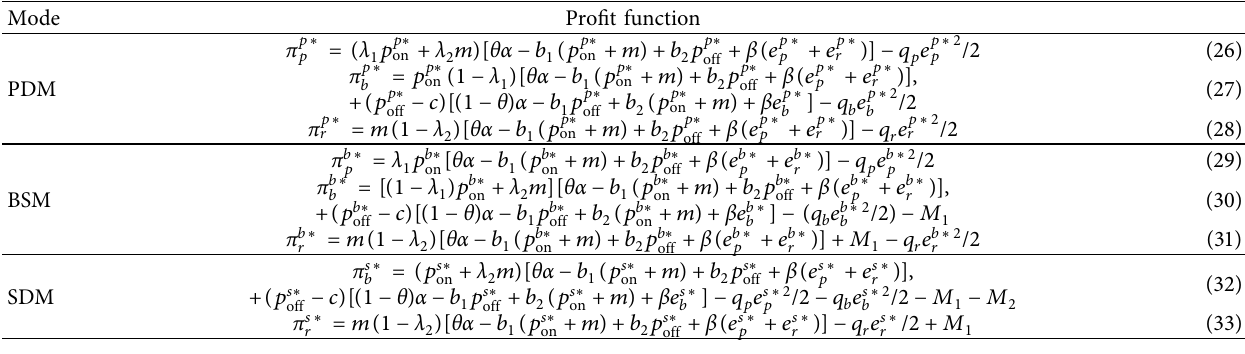
Table 2: Optimal profits under different decision